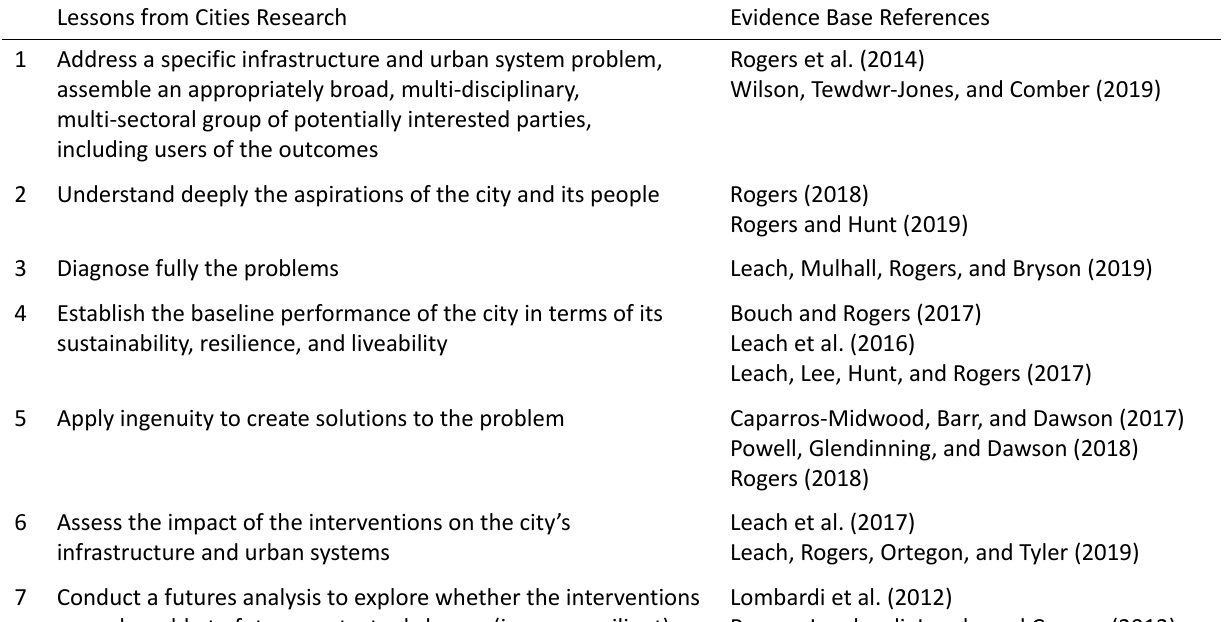
Table 1. Summary of the UKCRIC infrastructure and urban systems